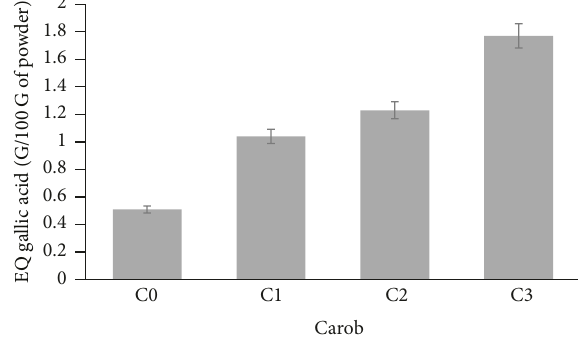
Figure 3: Total polyphenol content